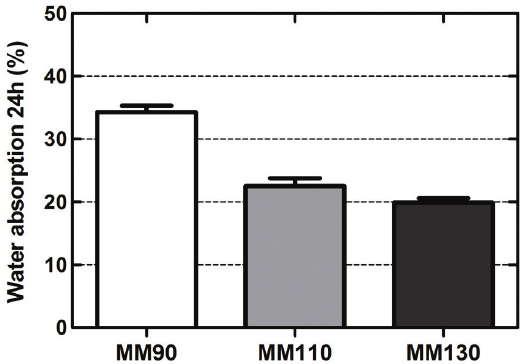
Figure 3. Water absorption of Tauari particleboards after 24 h of immersion.